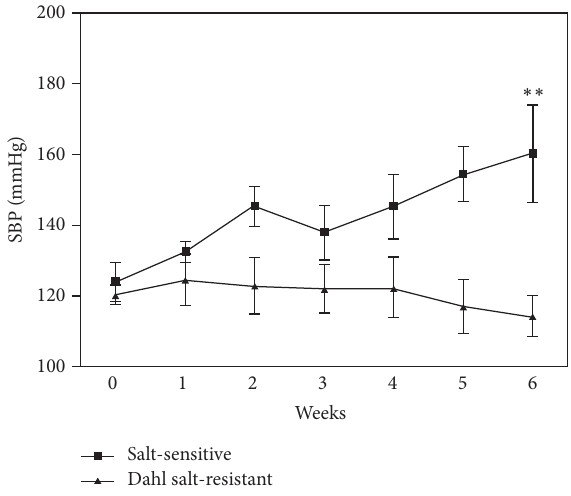
Figure 1: Figure 1 showed changes of systolic blood pressure between SR rats and SS rats. ∗∗ 𝑃 < 0.01 versus SR